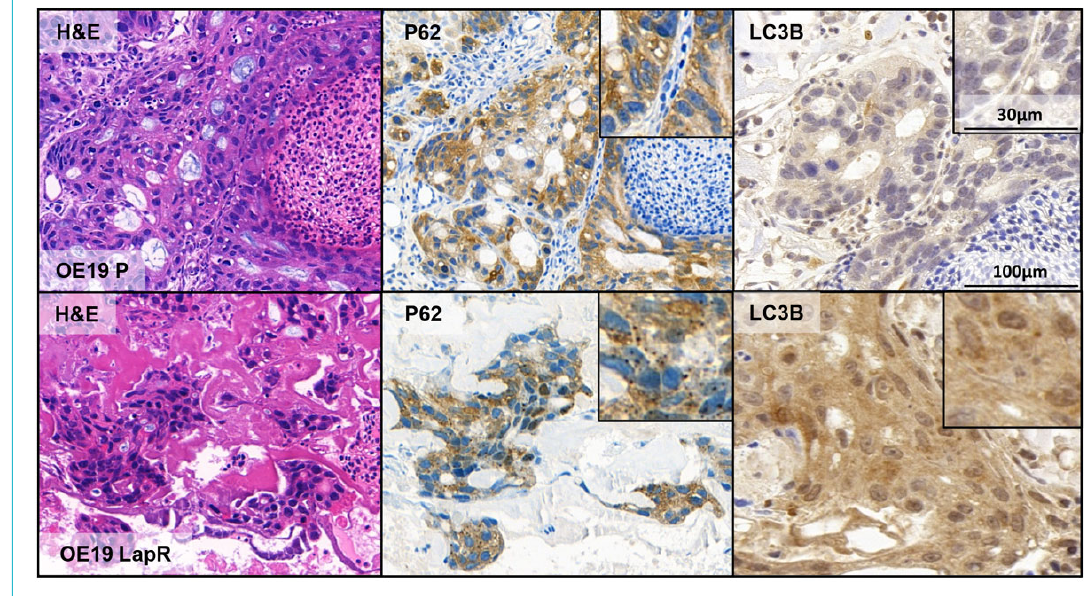
Figure 3: Increased autophagy in lapatinib-resistant OE19 oesophageal cancer cells. Microtumours developed from OE19 parental (OE19P) and OE19 lapatinib-resistant (OE19LapR) cells are shown in the upper and lower panels, respectively. Depicted from left to right are: H&E, p62 and LC3B staining. Lapatinib-resistant OE19 cells display p62 and LC3B dot formation indicative of increased autophagic activity compared to the parental cell line. The staining intensity of p62 corresponds to a score of 3+ and of LC3B to a score of 2+, according to Schläfli et al. [152].H&E = haematoxylin and eosin; p62 = sequestosome 1, SQSTM1; LC3B = microtubule-associated protein light chain